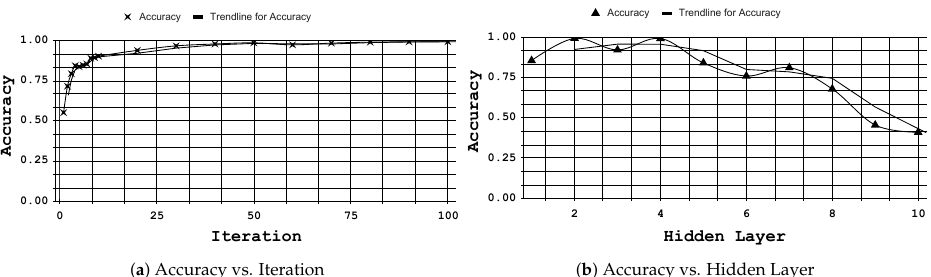
Figure 11. Accuracy optimization by iterations and hidden